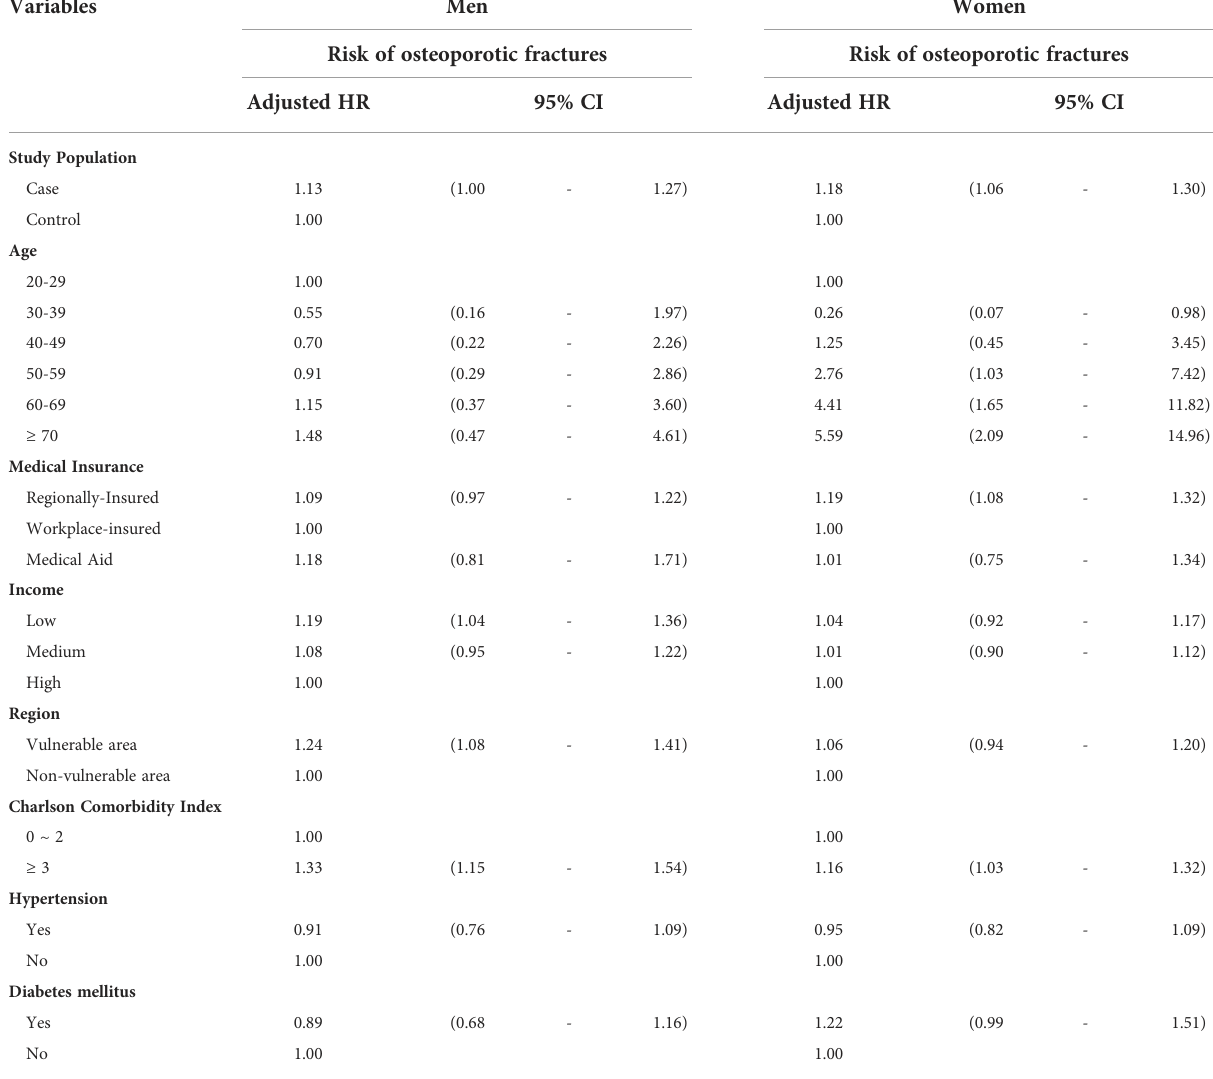
TABLE 2 Results of Cox proportional hazard regression analysis on the association between gastrectomy and risk of osteoporotic fractures.